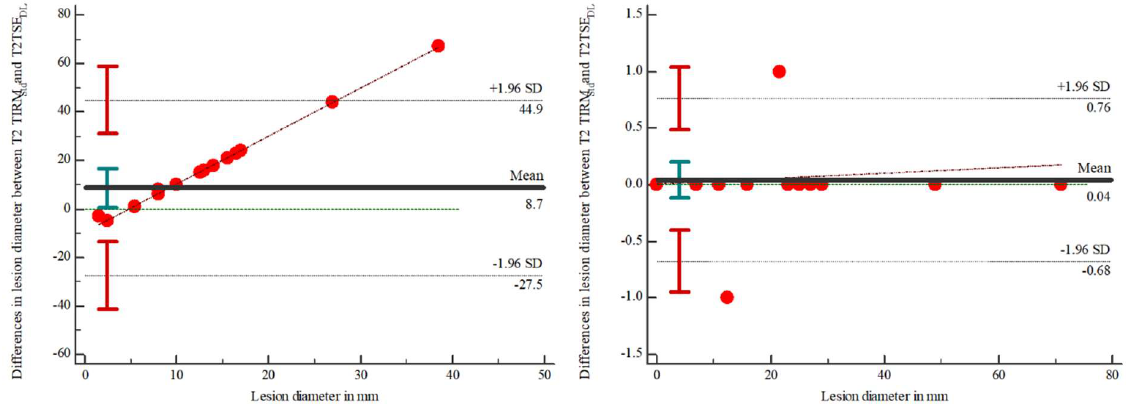
Figure 1. Bland-Altman plot to display the differences in the measurements of the lesion diameter between the T2-weighted TIRM Std and the TSE DL in reader 1 ( left ) and reader 2 ( right ).